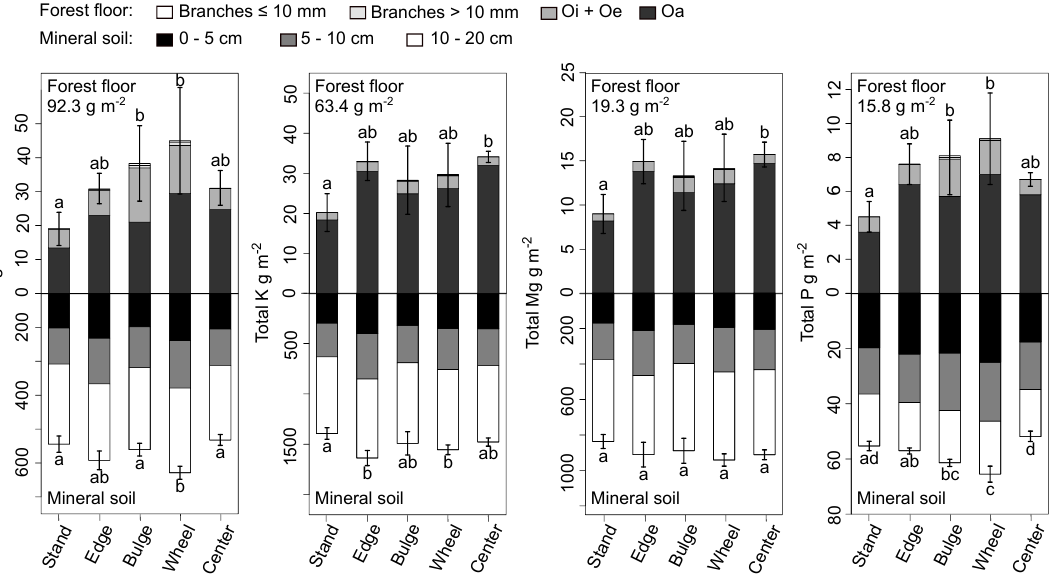
Figure 2. Total forest floor and mineral soil nutrient stocks by fraction, depth, and stratum in 2015. The entire stocks after deposition (deposited stock plus mean stand stock) are listed in the upper left for each nutrient. Letters indicate significant differences in complete forest floor or mineral soil nutrient stocks between strata (Dunn’s test, p < 0.05). Bars are one standard error of mean, complete stocks.